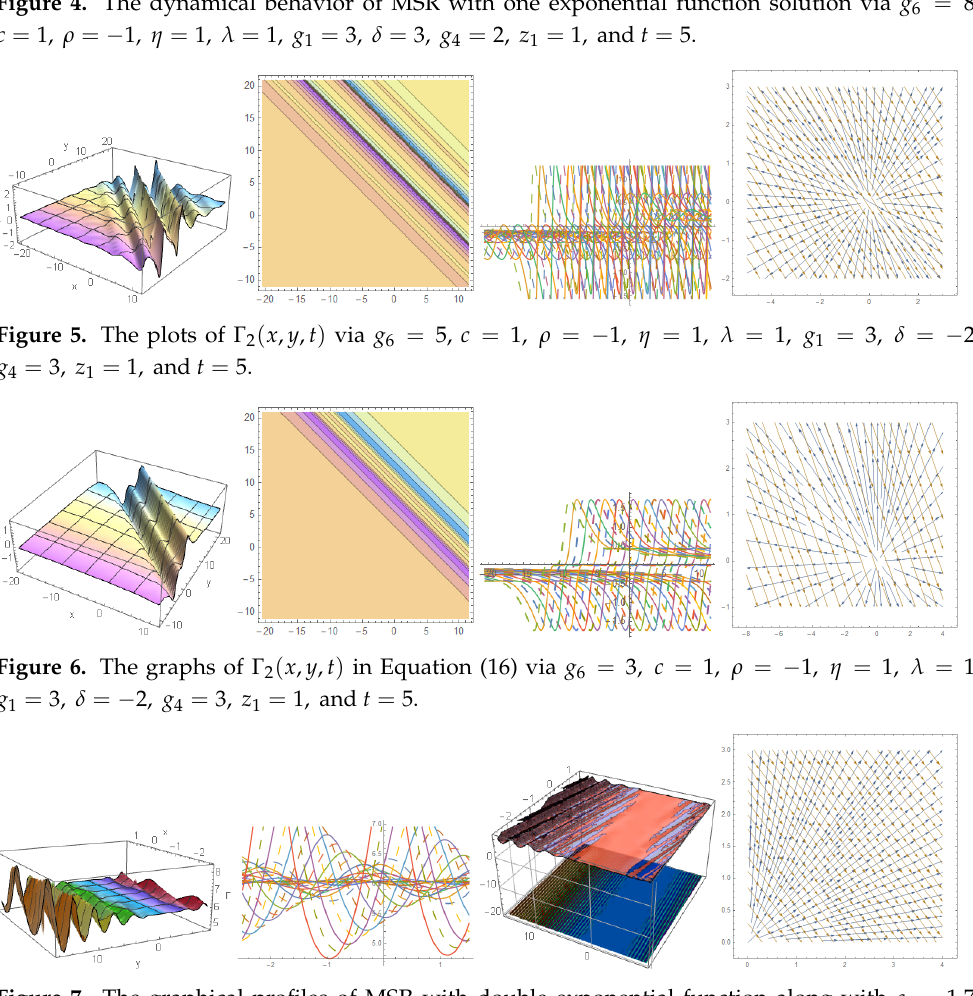
Figure 7. The graphical profiles of MSR with double exponential function along with c = 1.7,